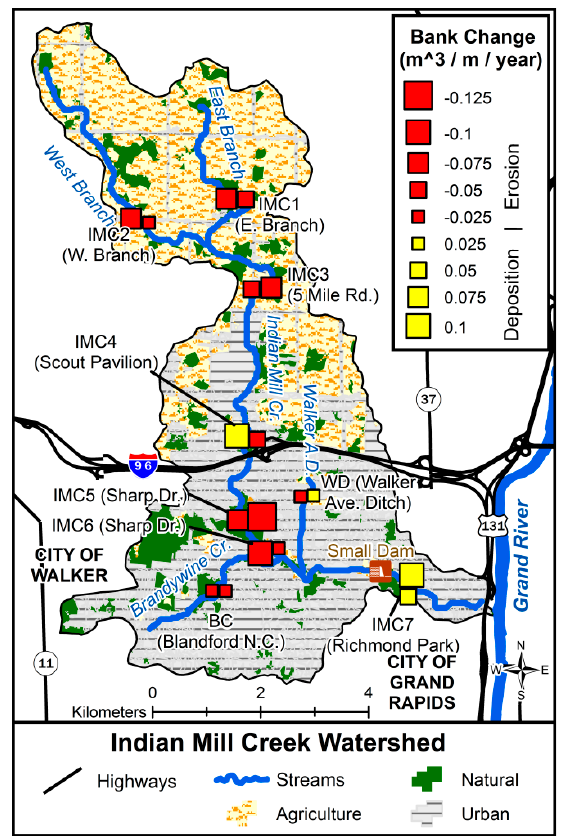
Figure 6. Spatial distribution of erosion (red) and deposition (yellow) rates for study streambanks using erosion pin results.